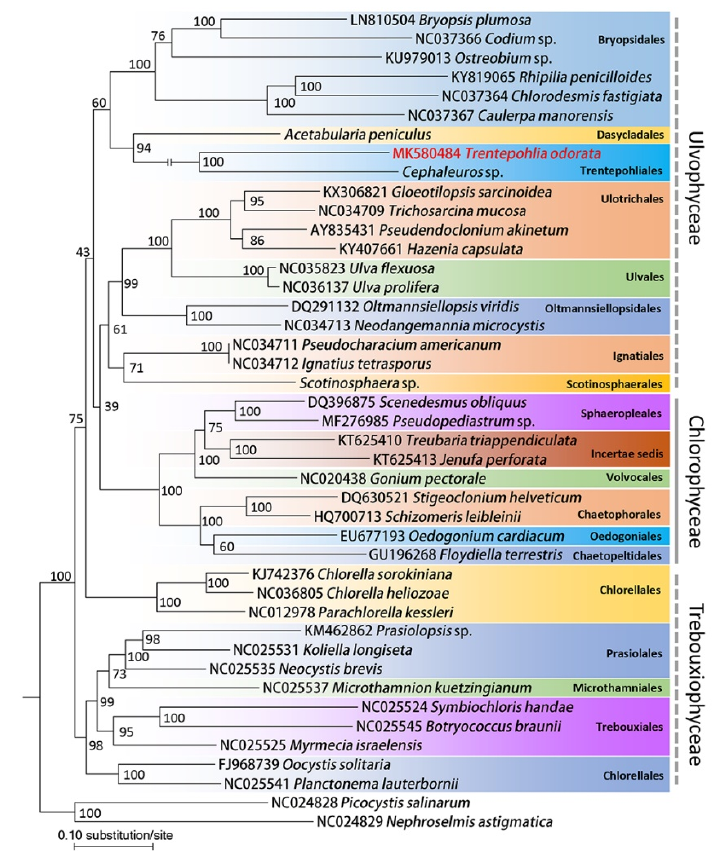
Figure 4. Maximum likelihood tree inferred from a dataset consisted of 31 common cpDNA-encoded genes of 43 core Chlorophytes. The genera Picocystis (NC024828) and Nephroselmis (NC024829) were selected as outgroup. Maximum likelihood bootstrap values (1000 replicates) are given near the nodes. Taxonomic arrangement follows AlgaeBase, and Trentepohlia odorata is in red.